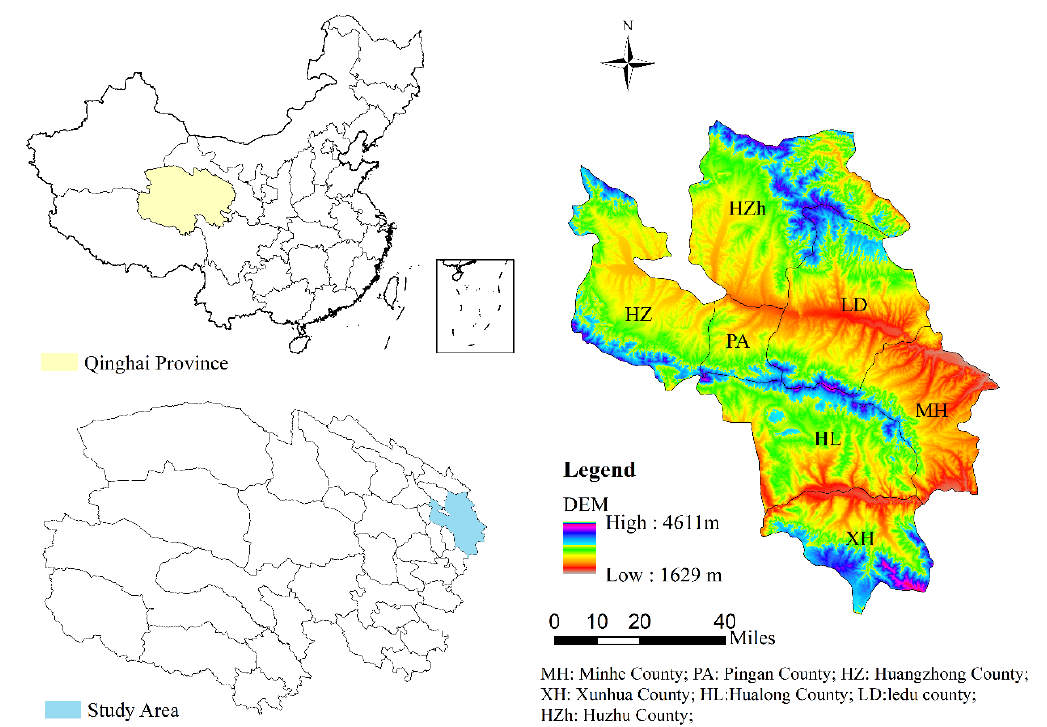
Figure 1. Location of a study on ecological security in the Qinghai–Tibet Plateau of the Qinghai alpine agricultural area.